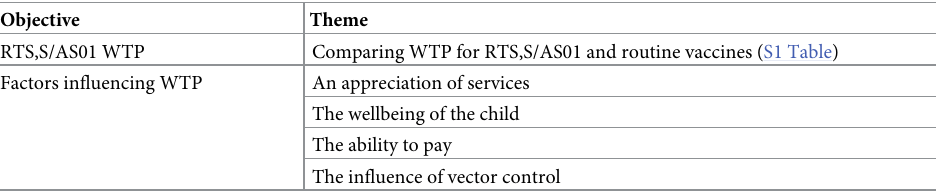
Table 2. Summary of themes.